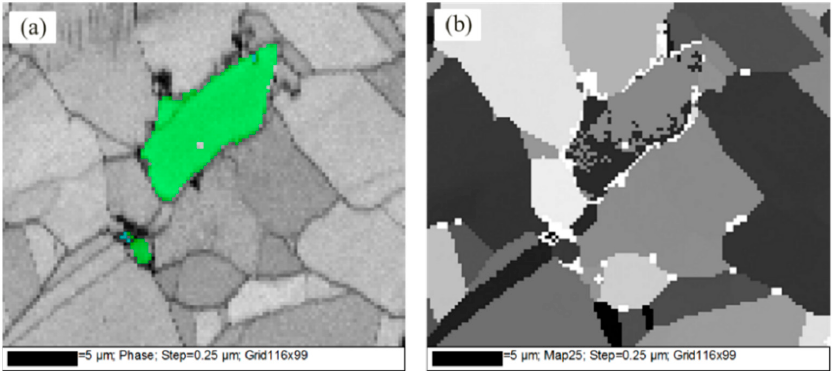
the overlapping technique: ( a ) constructed geometry file with phase and orientation information; and ( b ) white arrows highlighting the MgO-PSZ particle present inside steel grains.